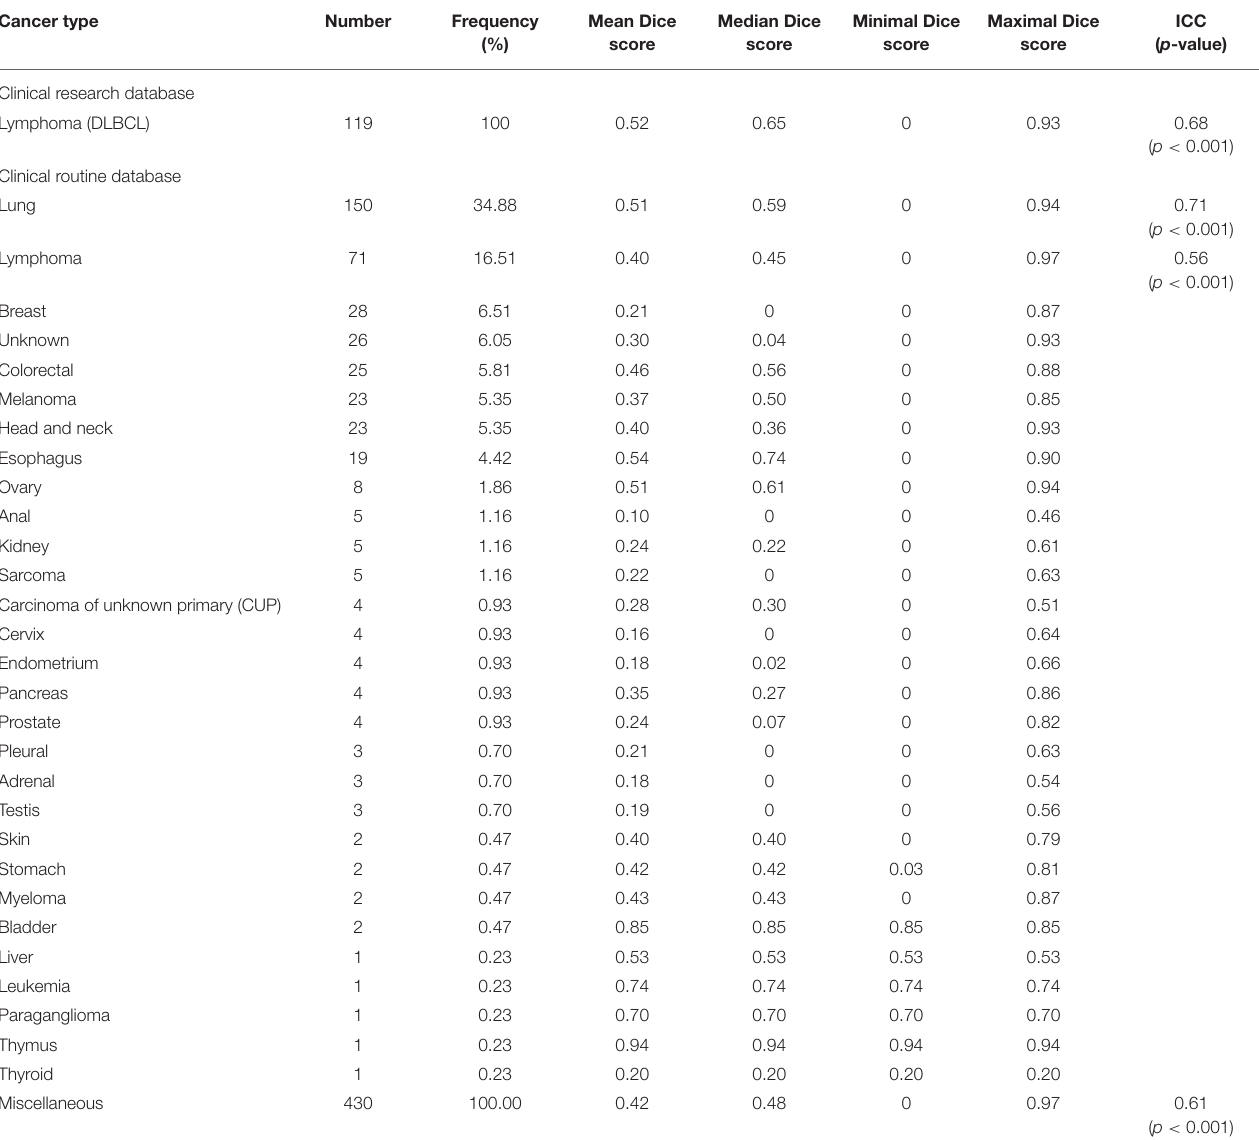
TABLE 1 | Summary results from two patient